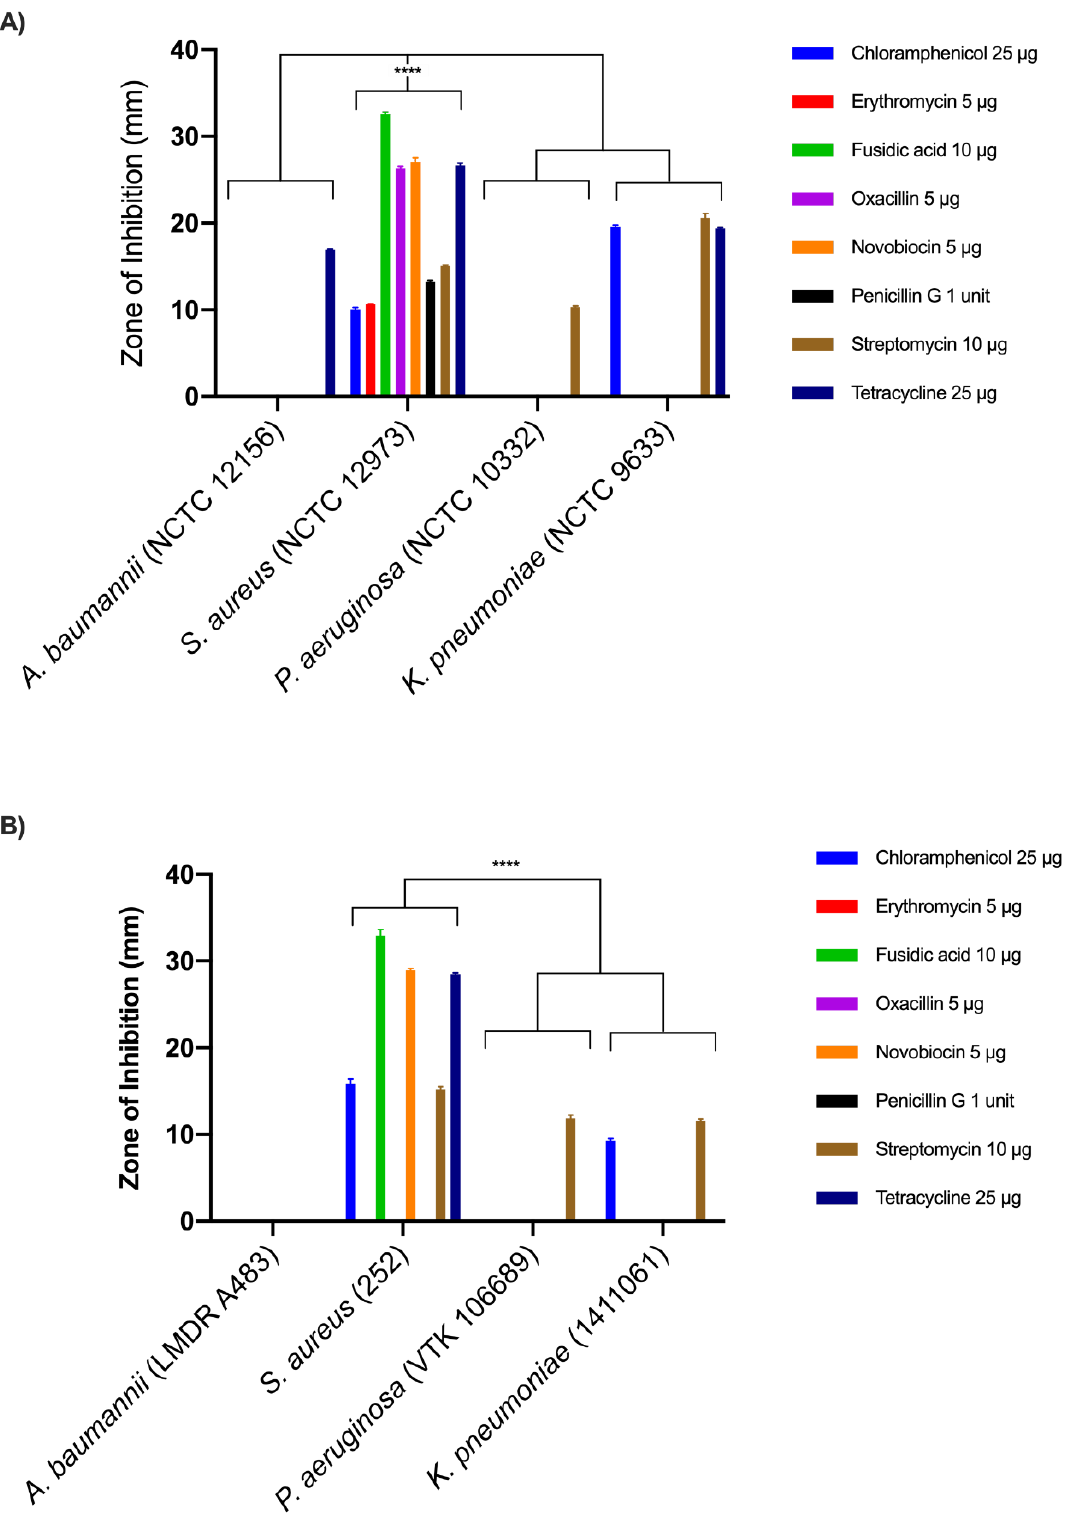
Figure 1. Antimicrobial susceptibility profiles against commonly used antibiotics against Gram-positive bacteria determined using MASTRING-S ® (M13/NCE) against, ( A ) susceptible bacterial strains and ( B ) resistant bacterial strains ( n = 3) **** p ≤ 0.0001.